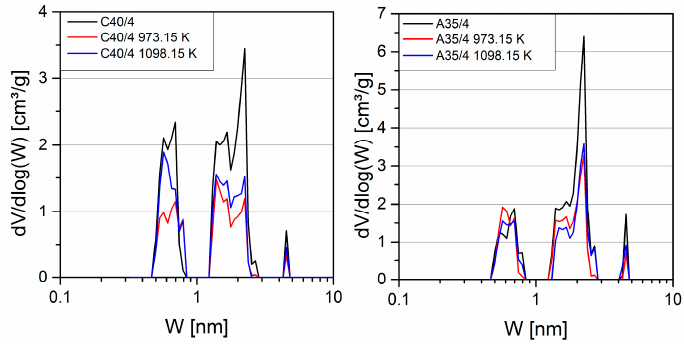
Figure 2. Pore size distribution by non-localized density functional theory (NLDFT) method.